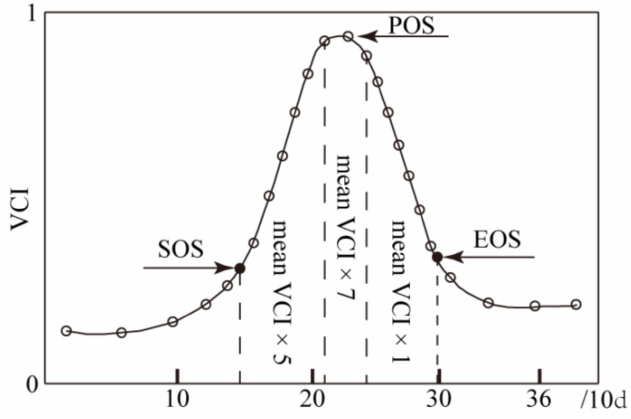
Figure 2. Schematic diagram for weighted vegetation condition index (WVCI)